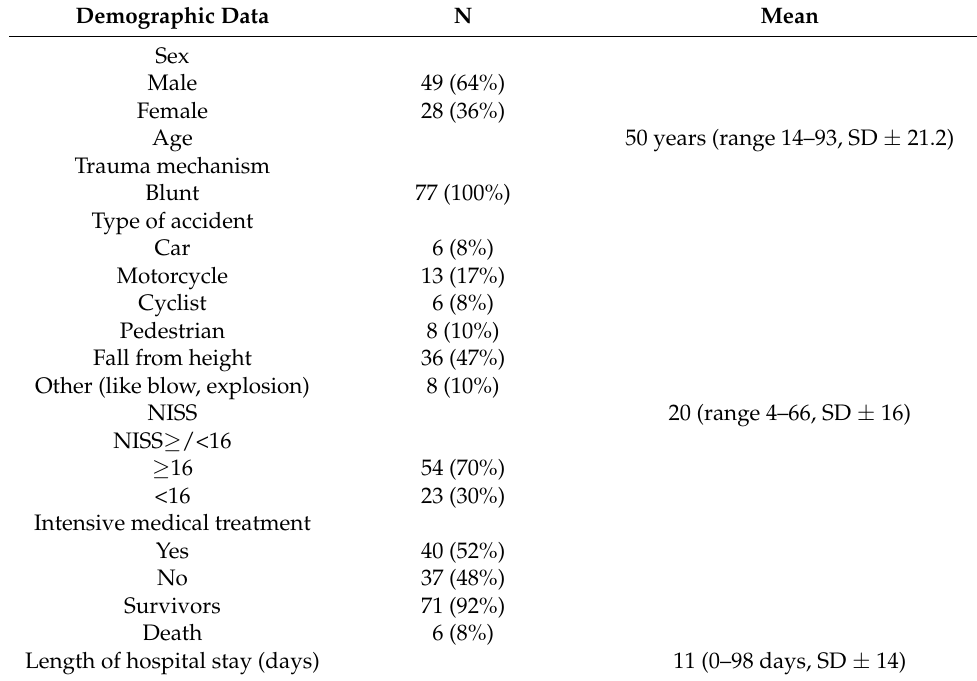
Table 1. Demographic data.